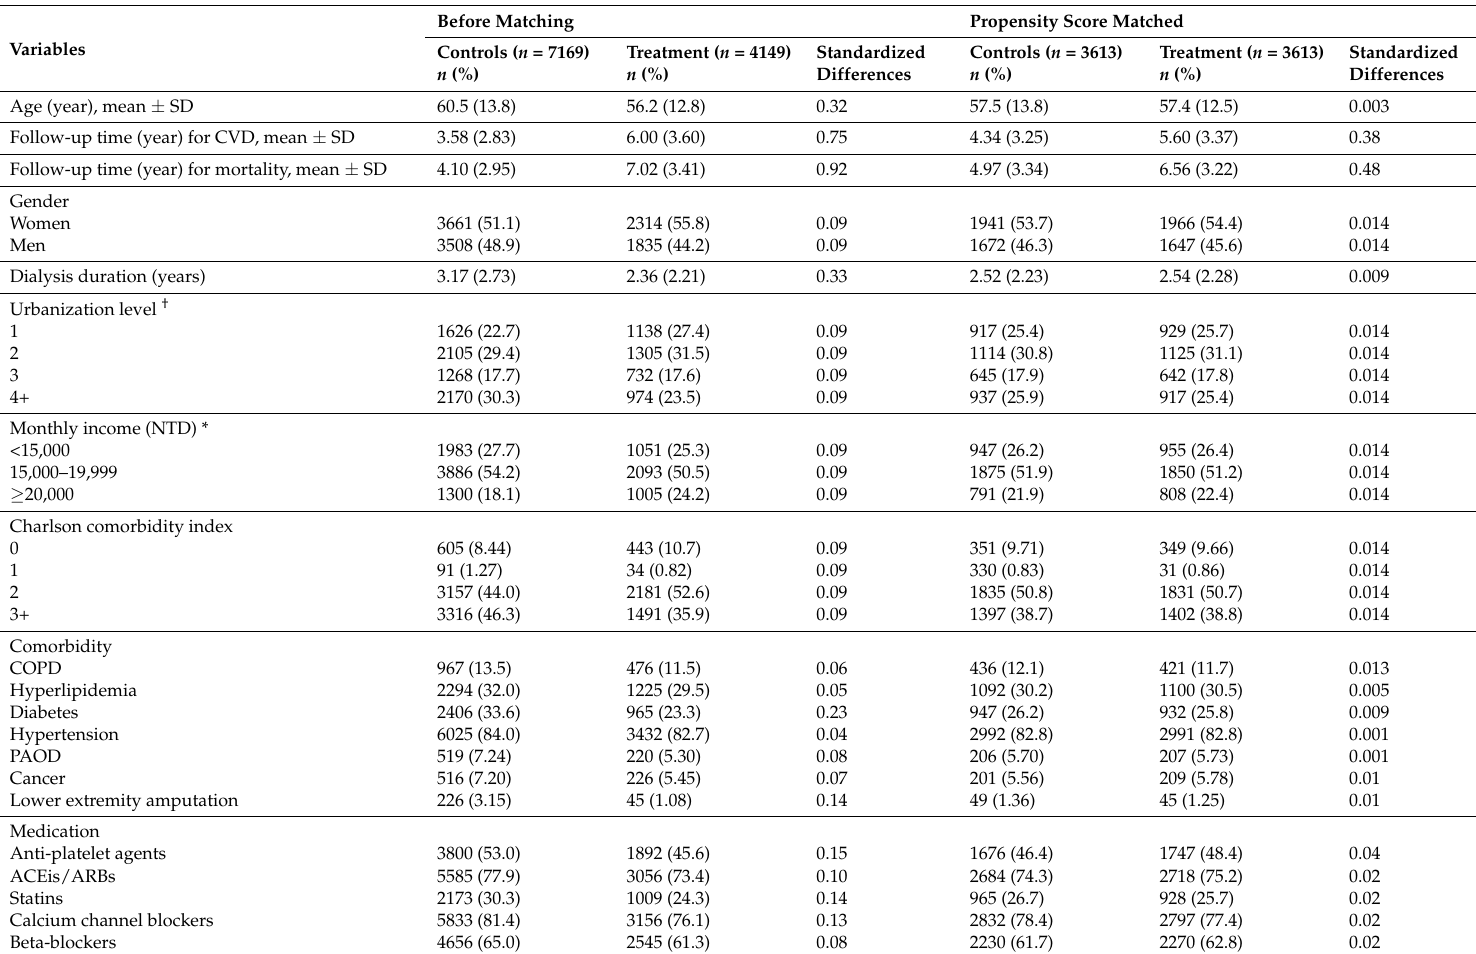
Table 1. Demographic status and comorbidity at baseline in hemodialysis patients with and without periodontal disease treatment.